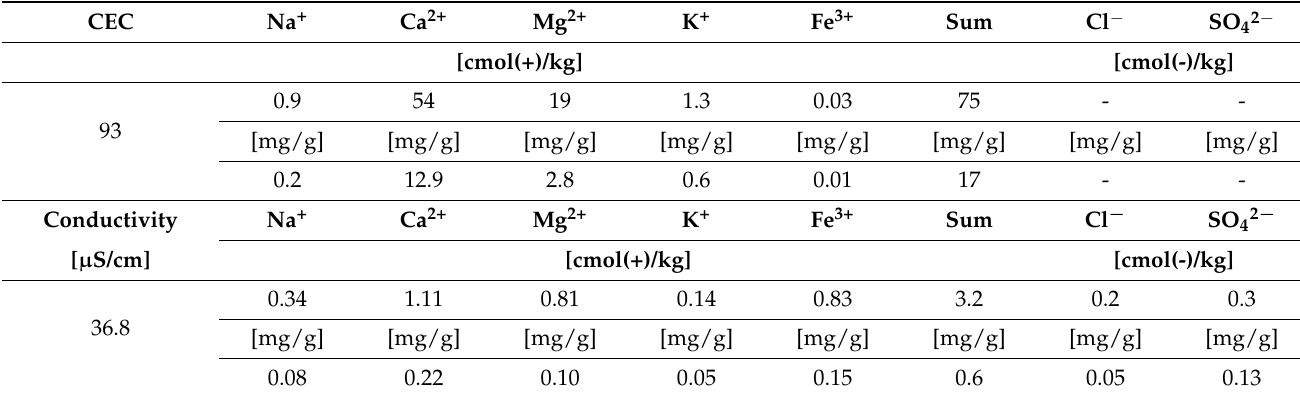
Table 6. CEC, exchangeable cations, conductivity of suspension and soluble cations and anions of Secursol UHP (granular material HTV-6 [5]).